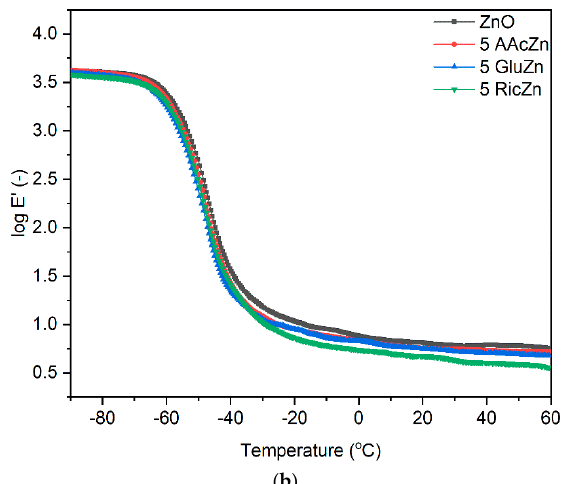
Figure 5. Storage modulus versus temperature of SBR vulcanizates with varying activators: ( a ) 3 phr, ( b ) 5 phr.